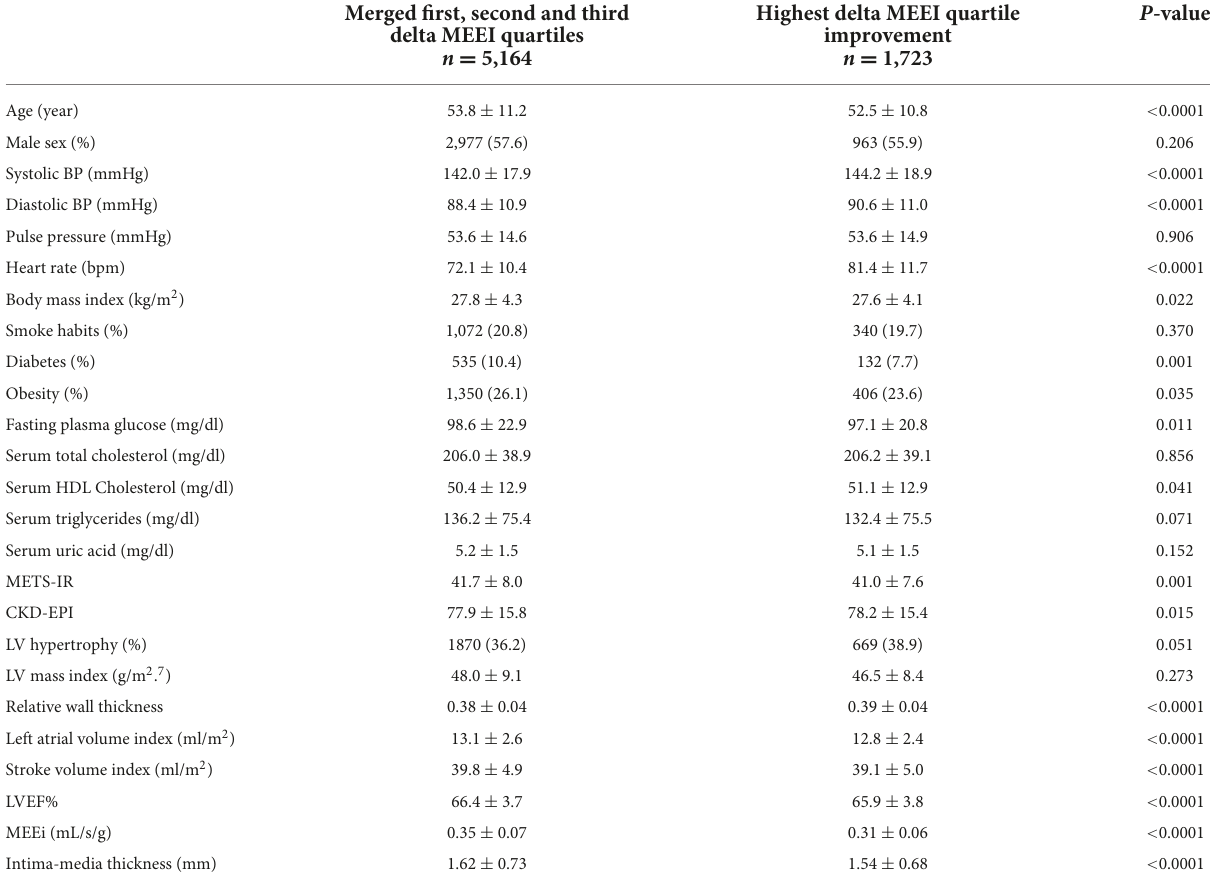
TABLE 1 Baseline characteristics of the study